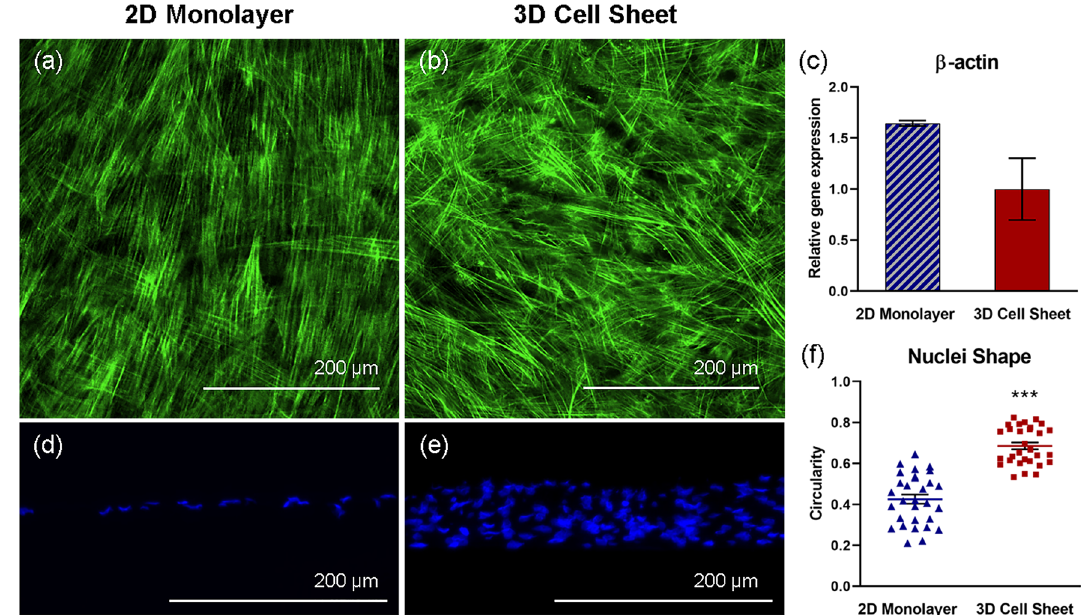
Figure 3. hUC-MSC actin structure changes in response to cell sheet contraction. Representative immunofluorescent images of hUC-MSC cytoskeleton (F-actin, green), imaged top-down, within ( a ) adherent 2D monolayers and ( b ) detached contracted 3D cell sheets. Cytoskeletal remodeling in response to cell sheet contraction is demonstrated by non-significant differences in ( c ) β-actin gene expression in hUC-MSCs in 2D monolayers and 3D cell sheets. hUC-MSC nuclei (DAPI, blue), imaged in cross-section, are elongated within the aligned cytoskeletal structure in ( d ) 2D monolayers and are significantly more rounded within the 3D cytoskeletal organization in ( e ) 3D cell sheets, evidenced by ( f ) nuclei circularity quantification. Scale bars = 200 μm. Values are means ± SE (n = 30: *** p <